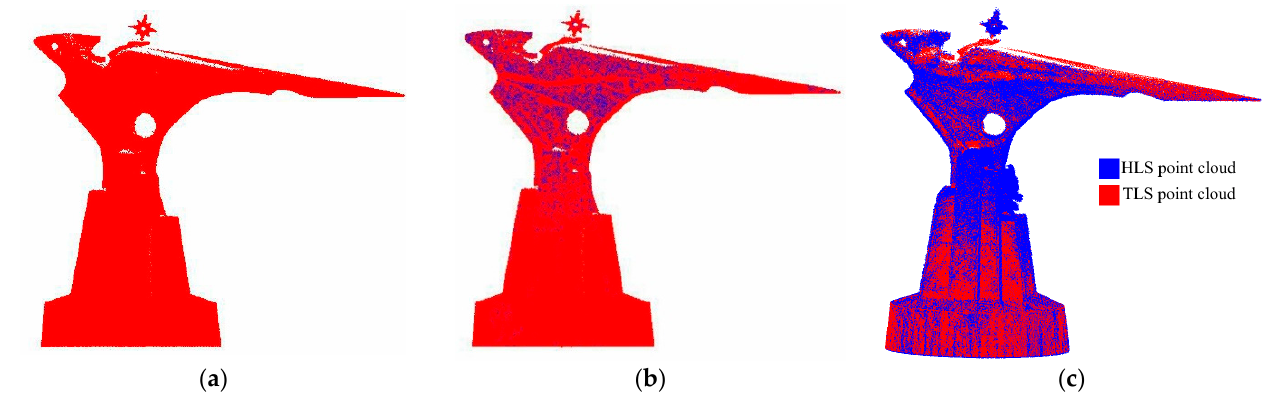
Figure 16. Rendering of point cloud fusion. ( a ) TLS point cloud. ( b ) Point cloud merged by feature points. ( c ) Direct merging of point clouds. points. ( c ) Direct merging of point clouds.